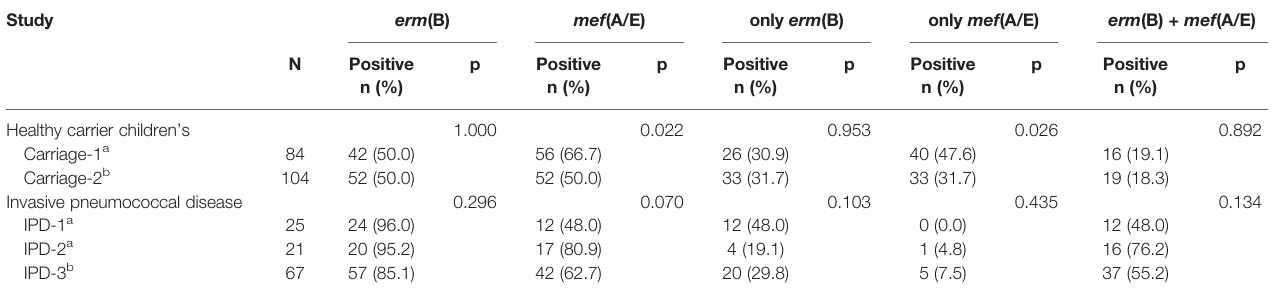
TABLE 2 | Distribution of macrolide resistance genes.